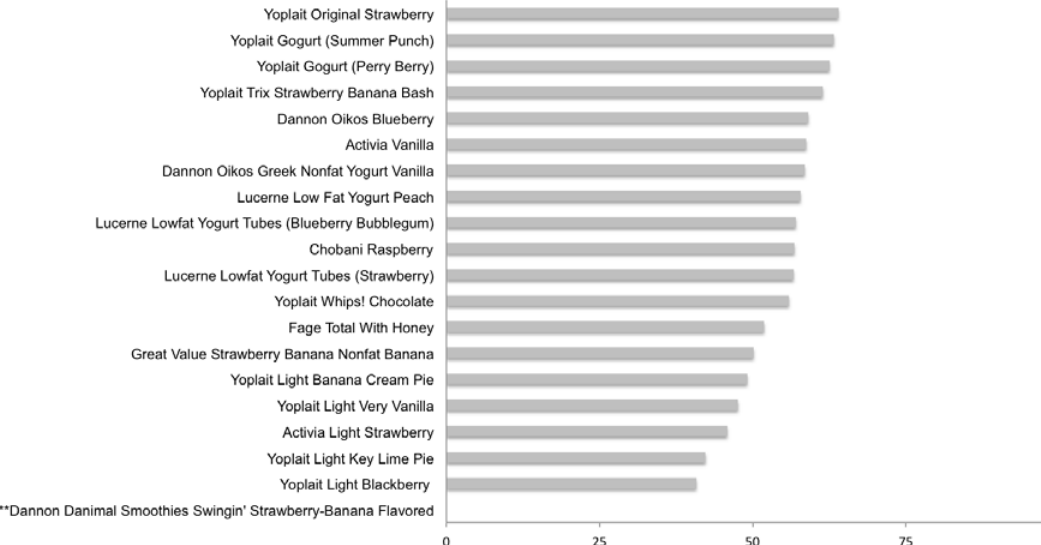
Figure 3. Percent of total calories from sugar: Yogurt. ** Label specifies no sugar. Values were derived from the following equation: % Total Calories from sugar = [(Total Sugar Actual per serving × 4)/Total Calories per serving] × 100.